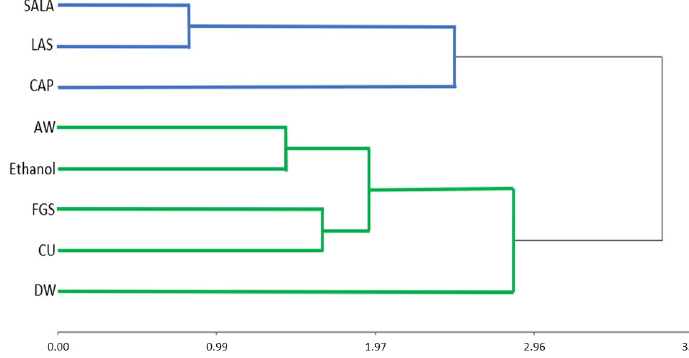
Figure 8. Hierarchical cluster analysis. DW: distilled water, AW: Acetone: water, NaDES: LAS, CAP, FGS, SALA, CU.